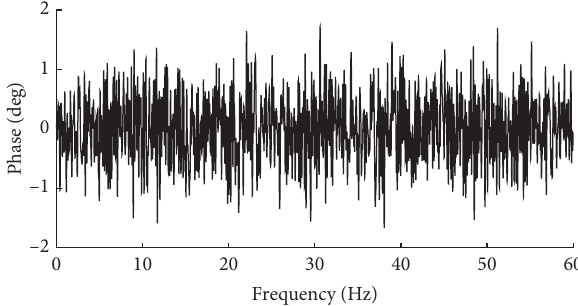
Figure 6: Phase spectrum of Wenchuan wave.